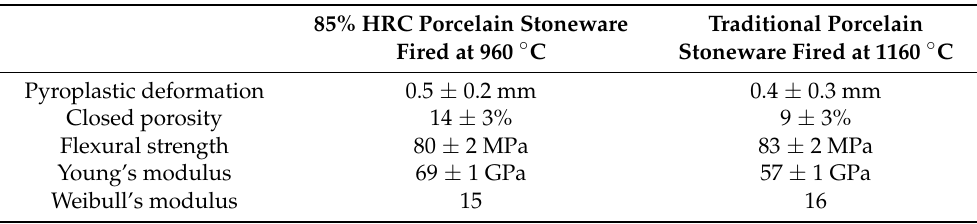
Figure 5. SEM micrographs of polished and etched sample surfaces. ( A ) 85% HRC sample fired at 960 ◦ C showing wollastonite an plagioclase crystals; ( B ) porcelain stoneware sample fired at 1160 ◦ C showing elongated mullite crystals. Table 4. Main characteristics of 85% HRC and traditional porcelain stoneware materials sintered in the laboratory furnace.